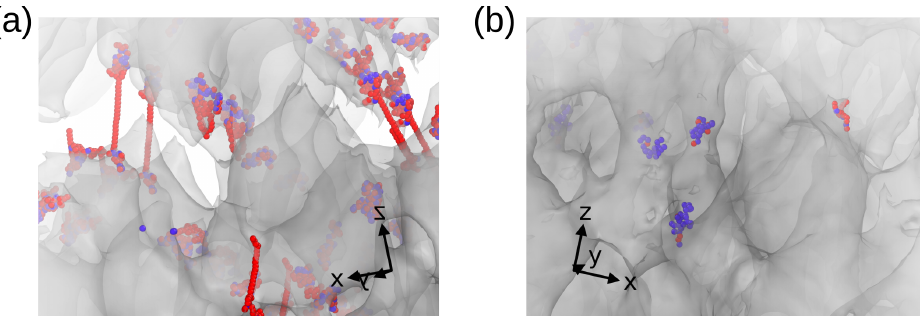
Figure 10. Bond breaking during the fracture process of the filaments. Snapshots correspond to the strain of 0.35 for samples of 49.1% ( a , b ) of 10.8% of sp 3 . Around the fracture, atoms are colored according to their coordination, which is lower than other atoms in their neighborhood. Red and blue atoms show coordination 1, and 2,